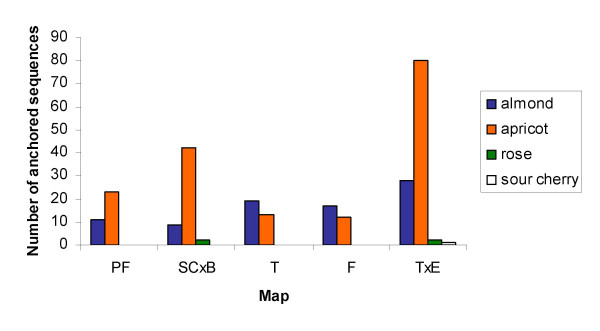
Case Study result: Number of anchored Rosaceae sequences to various Rosaceae genetic maps T × E: 'Texas' × 'Earlygold'; F or T: F × T ('Ferragnes' × 'Tuono'); P × F: ('IF310828' × P. ferganensis) × 'IF310828'; SC × B: 'Suncrest' × 'Bailey'